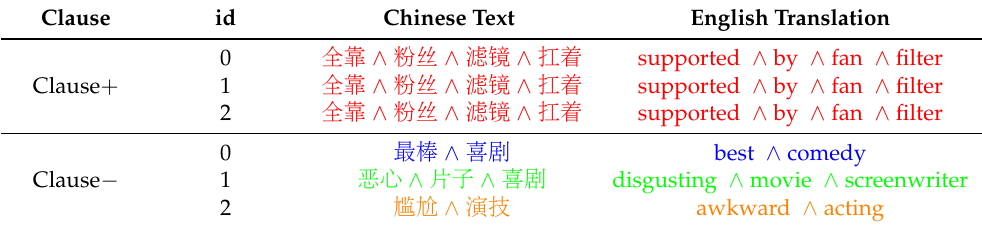
Table 14. Literals learning results in Spam Review